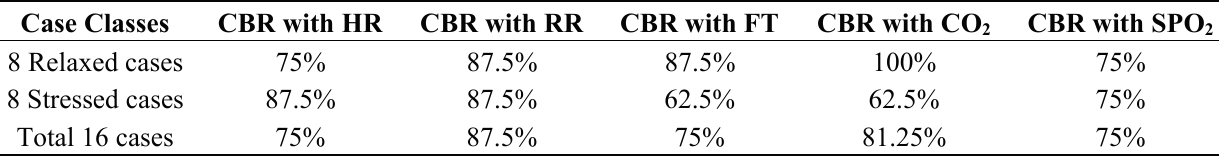
Table 4. Classification accuracy considering CBR with single signal source. Here, HR = Heart Rate, FT = Finger Temperature, RR = Respiration Rate, CO = Oxygen and SPO 2